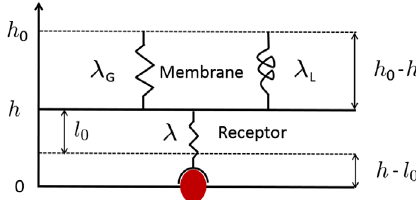
FIG. 7. Schematic representation of the mechanical model membrane. The model consists of three coupled springs. The membrane is represented by two parallel springs: one harmonic [deformation energy quadratic in extension, λ G ð h − h 0 Þ 2 ] and the other linear [deformation energy linear in extension, ffiffiffiffiffi p λ j ], with the rest position of both springs at h j h − h L 0 receptor is represented by a harmonic spring of stiffness λ and rest length l 0 , which is coupled in series with the parallel membrane